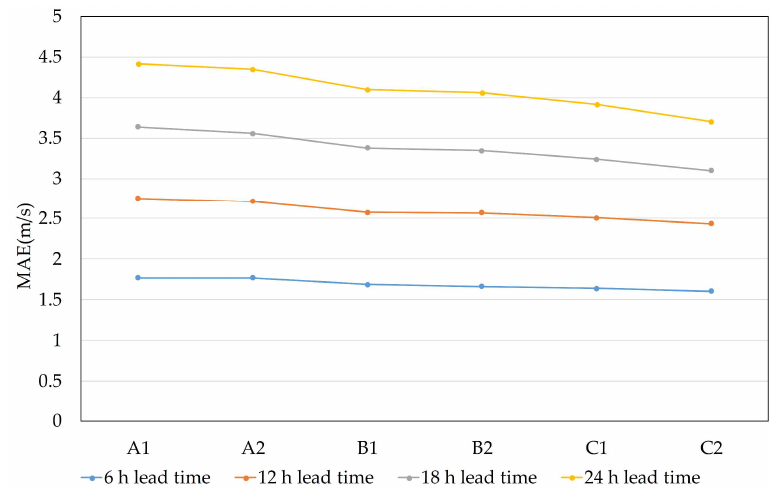
Figure 3. Mean absolute prediction errors of the TC intensity at 6, 12, 18, and 24 h lead times. MAE: mean absolute error.